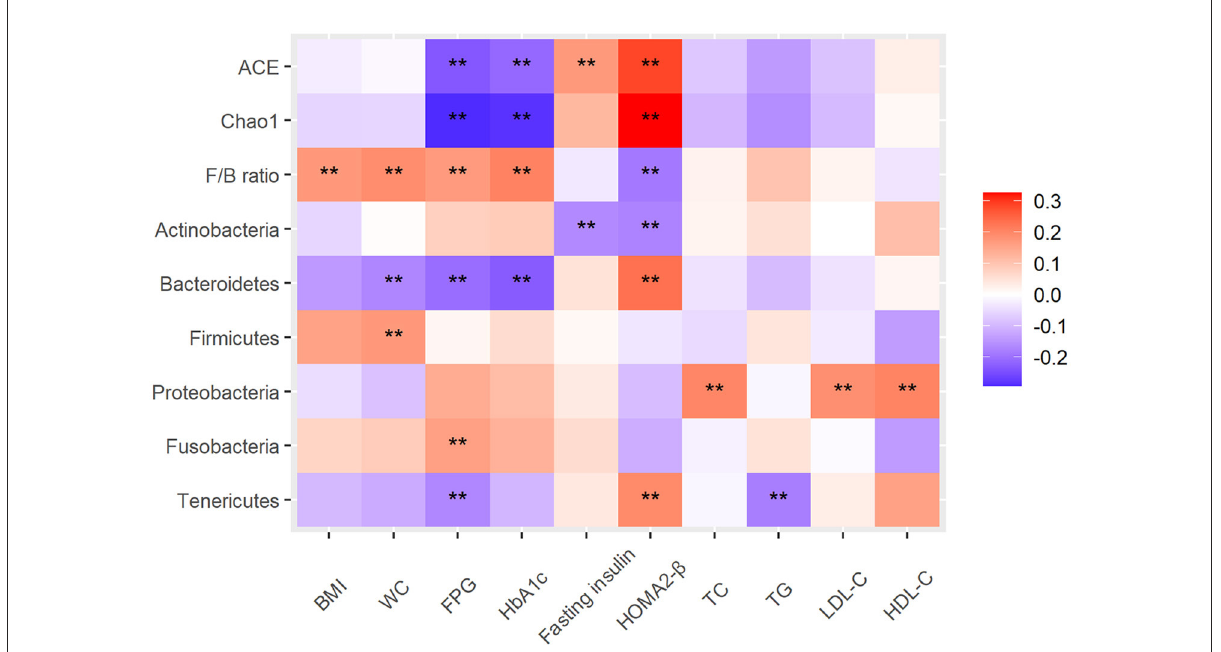
FIGURE4 Heat map of the Spearman correlation between intestinal microbiota and type 2 diabetes–related traits. The intensity of the colors represents the degree of association as measured by the Spearman correlation. All significant correlations are marked with an asterisk ( P < 0.05). Alpha diversity index, ACE, Chao1; F/B ratio, ratio of Firmicutes/Bacteroidetes; BMI, body mass index; WC, FPG, fasting plasma glucose; HOMA2- β , Homeostatic model assessments2 of beta-cell function; TC, total cholesterol; TG, triglycerides; LDL-C, low-density lipoprotein cholesterol; HDL-C, high-density lipoprotein